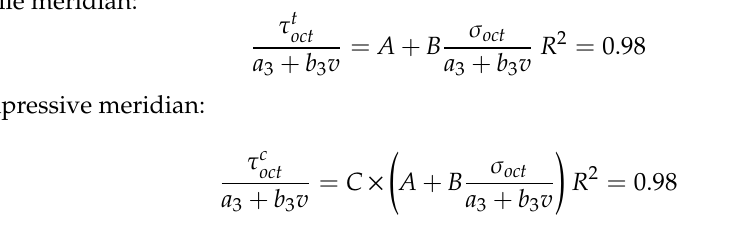
Table 10. Test results of asphalt mixture under different loading rates.